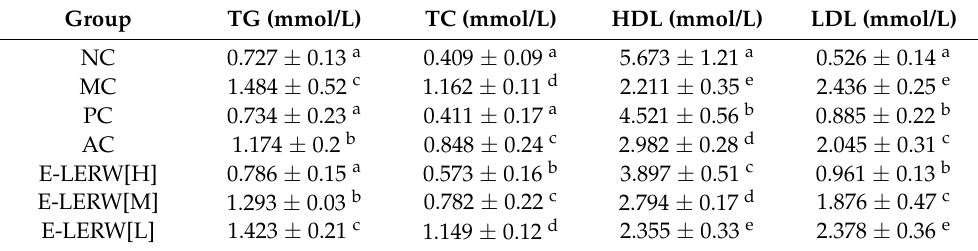
Table 3. Lipid levels of mice treated with astilbin and E-LERW of different doses. Group